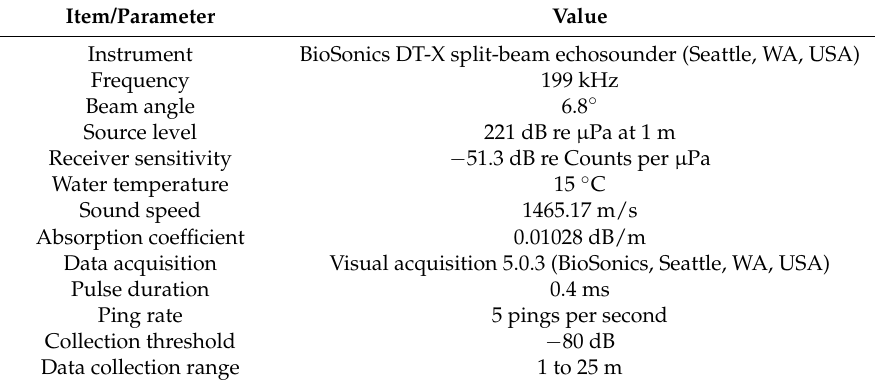
Table 2. Six Chinese sturgeons used for conducting the ex situ target strength